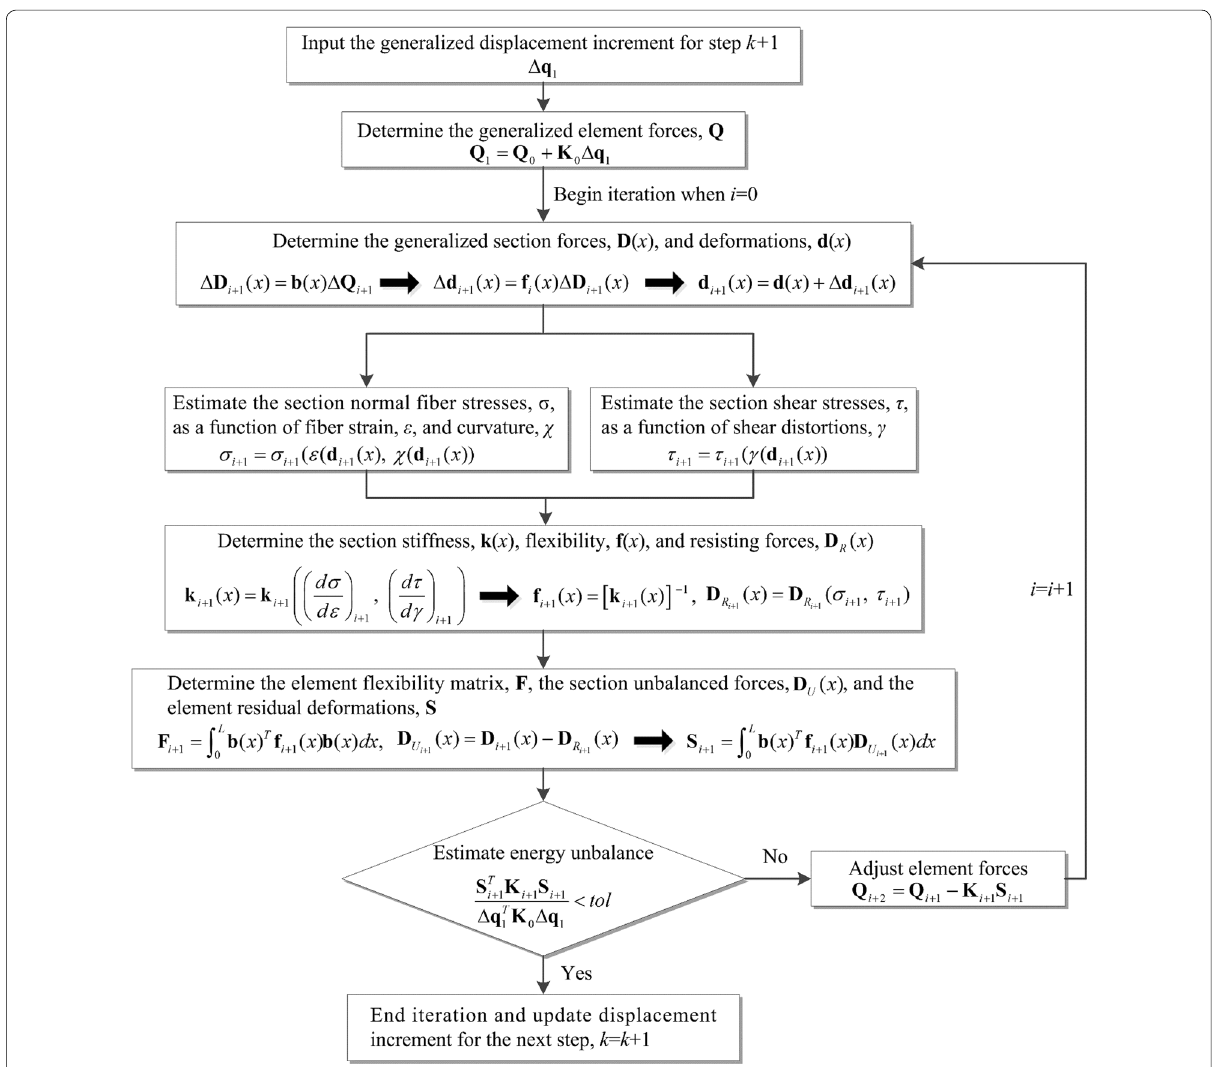
Fig. 3 Schematic statement of the iteration involved in the MFBFE algorithm.